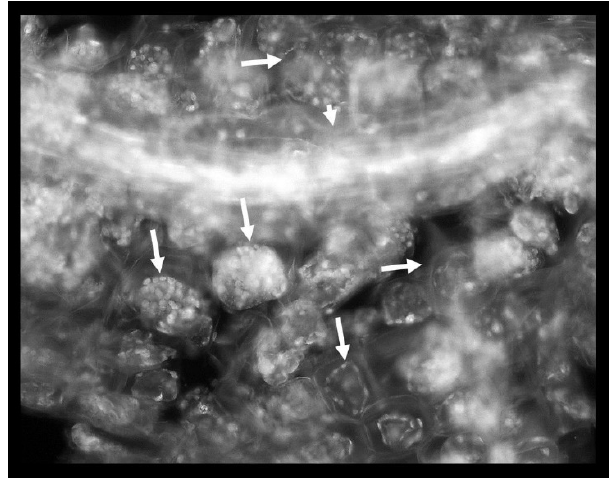
Figure 4. Phenol-induced root damage is represented by the abundance of intensely autofluorescing plastids and extensive plasmolysis (arrows). Short arrow: a vascular bundle.